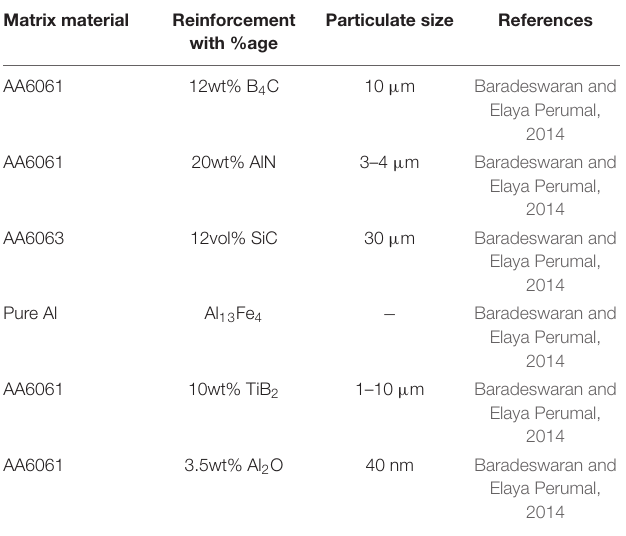
TABLE 4 | Reinforcement composition in different types of Aluminum matrices. Matrix material Reinforcement Particulate with %age